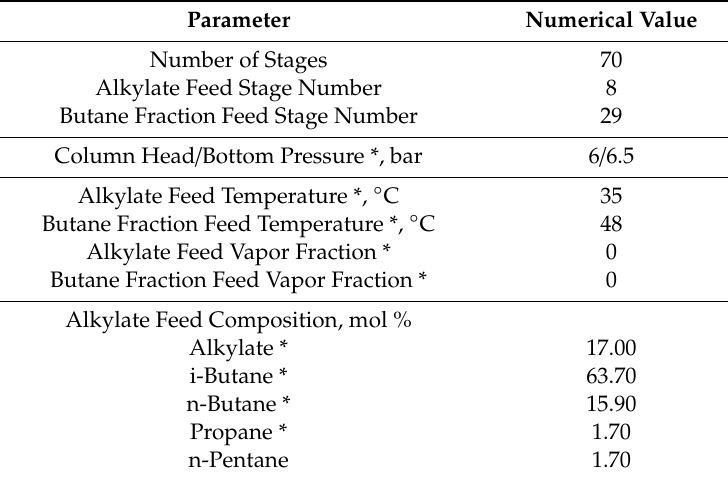
Table 1. Fixed values of model